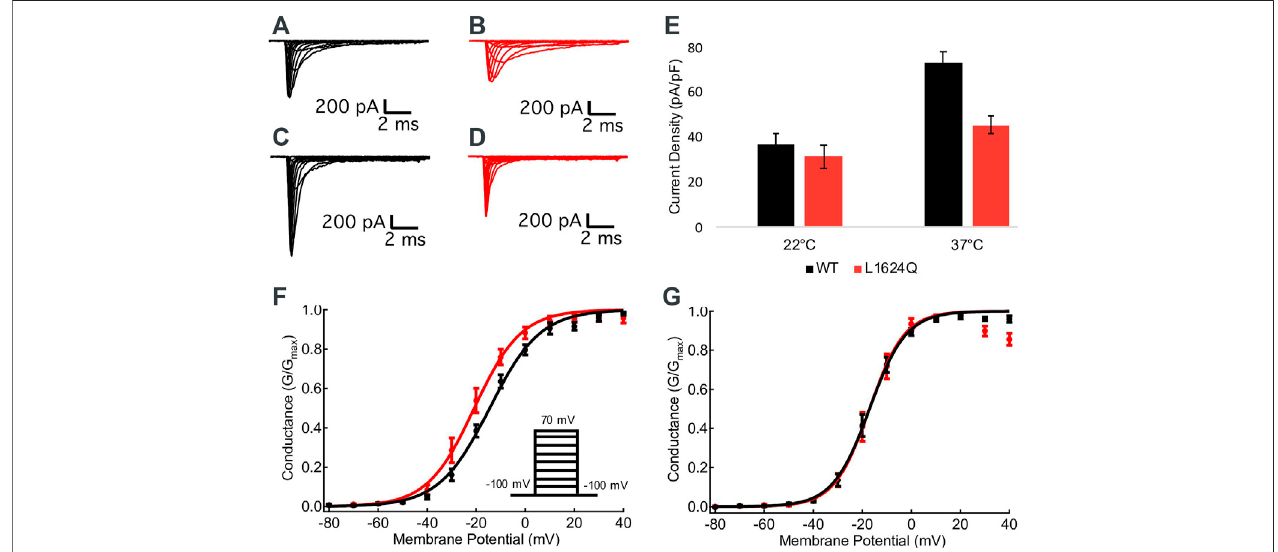
FIGURE2| L1624Qreduces peakcurrentdensity. (A – D) :Representativemacroscopicinward sodiumcurrents.WT(black)andL1624Q(red)tracesareshownat 22 ° C (A,B) and 37 ° C (C,D) . (E) : Bar chart comparing mean sodium current density at 0 mV in WT and L1624Q cells at 22 ° C (n WT (cid:1) 28, n LQ (cid:1) 28) and 37 ° C (n WT (cid:1) 28, n LQ (cid:1) 41). (F,G) : Normalized conductance curves for WT (black) and L1624Q (red) channels are shown at 22 ° C ( (F) , n WT (cid:1) 7, n LQ (cid:1) 6) and 37 ° C ( (G) , n WT (cid:1) 10, n LQ (cid:1) 8). Insets show the voltage protocol. All midpoint measurements are means and error bars represent standard error of the